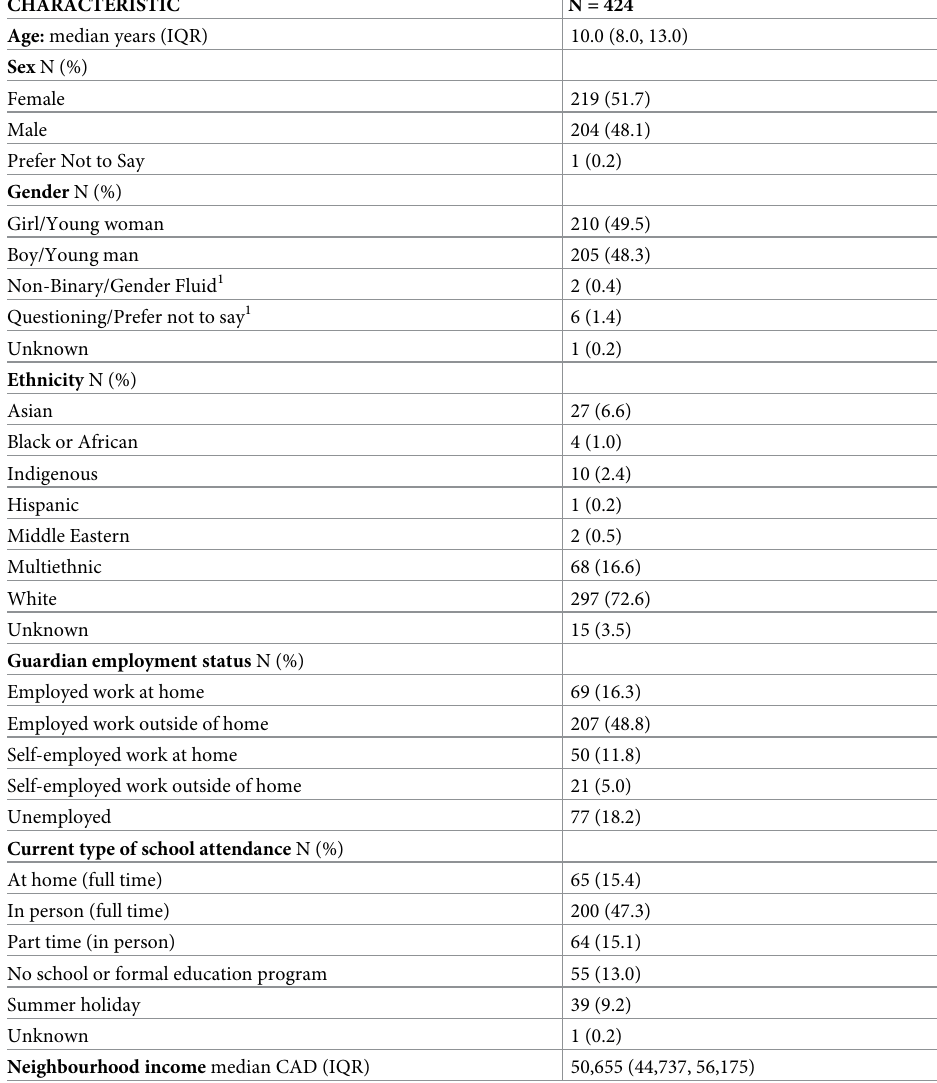
Table 1. Participant demographic and pandemic related experience